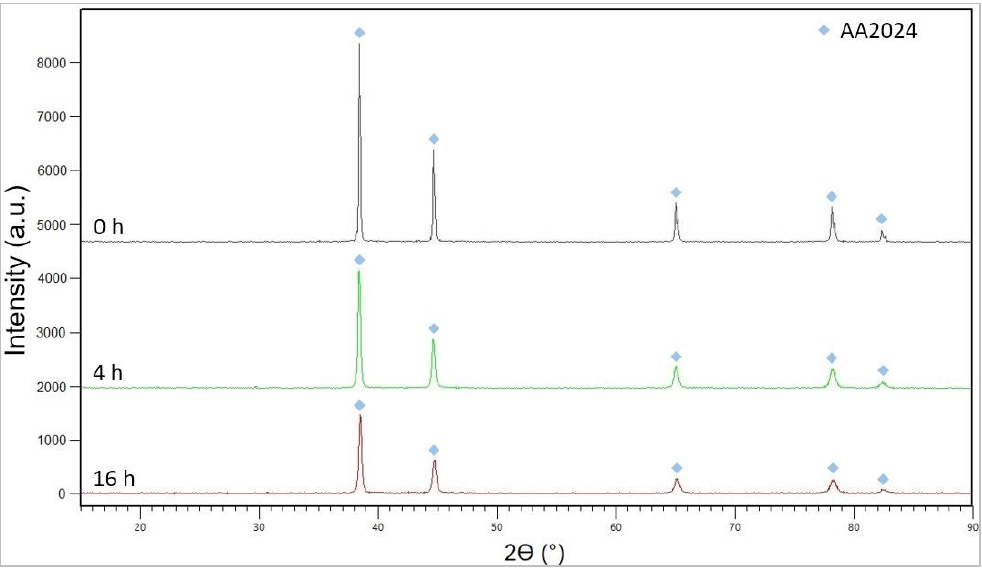
Figure 6. XRD patterns of 0, 4 and 16 h milled